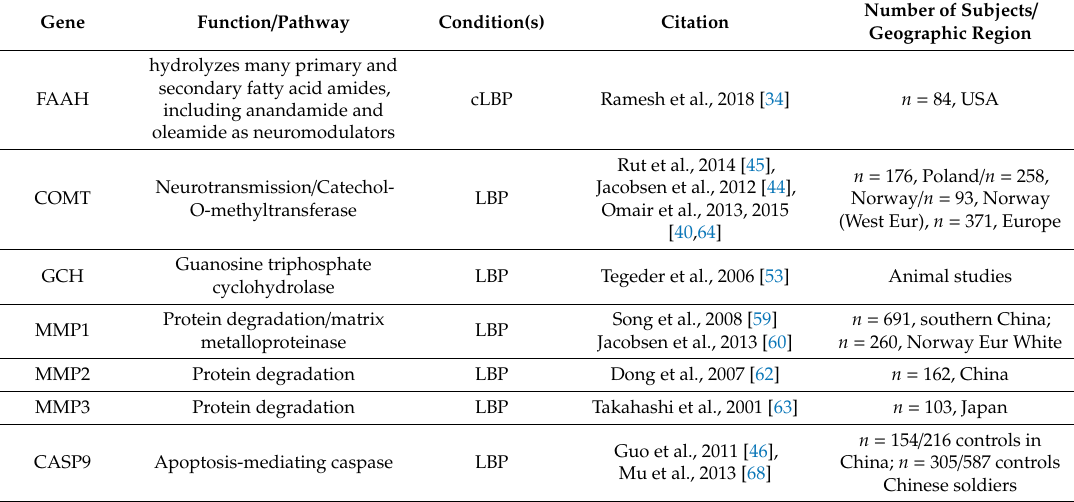
Table 2. Enzyme-related